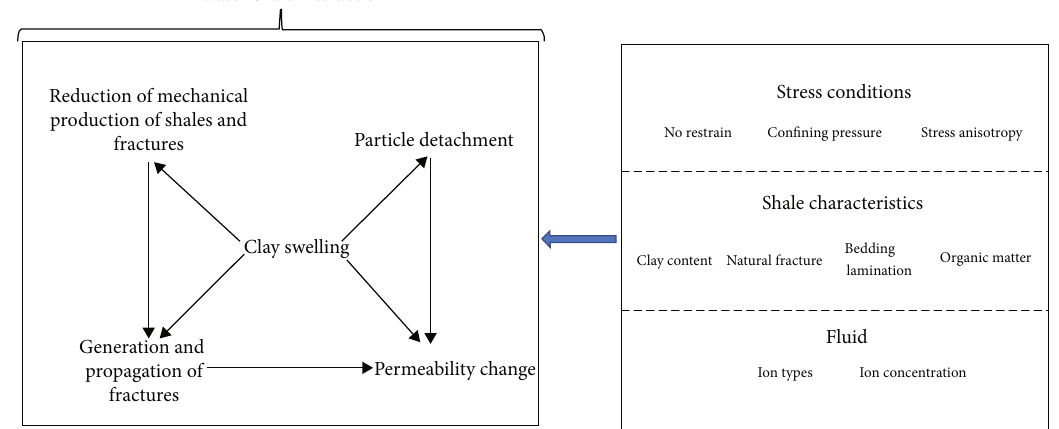
Figure 23: Phenomena appearing in water-shale interaction, the impact between these processes, and the other in fl uencing